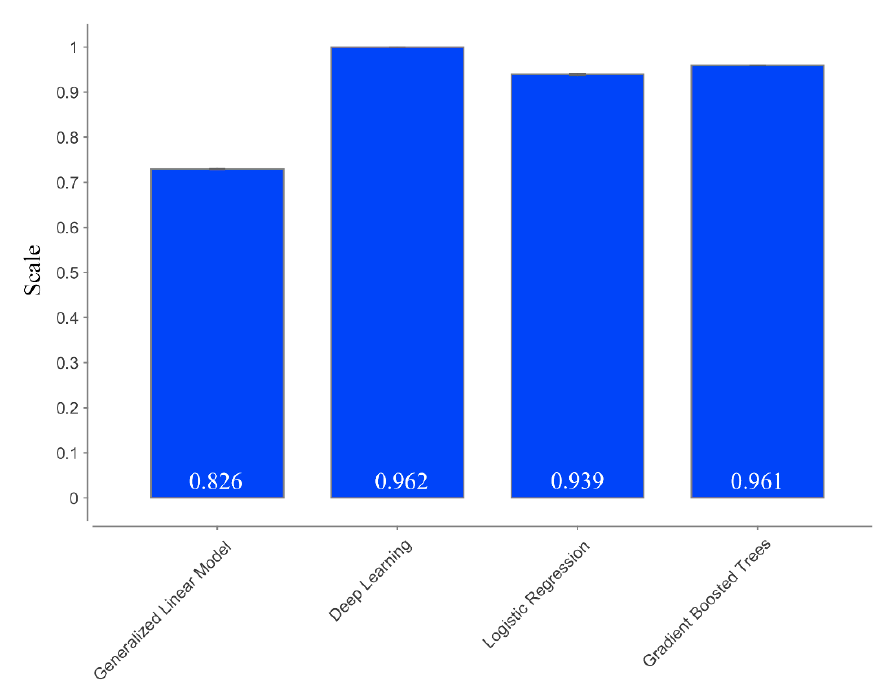
Figure 4. Graphical representation of AUC.